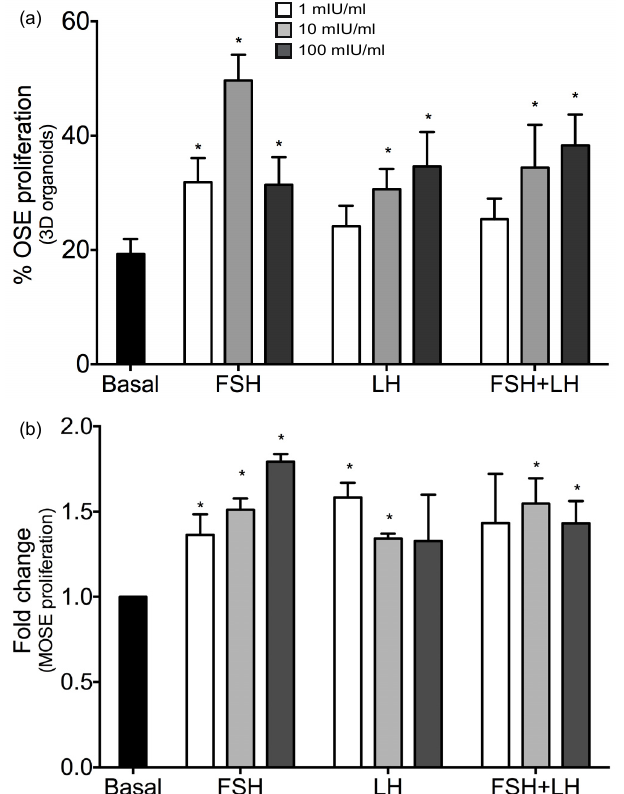
Figure 1. Gonadotropins increase ovarian surface epithelium (OSE) proliferation in 3D organoids and mouse ovarian surface epithelial (MOSE) cell line. ( a ) Using BrdU as a marker of DNA synthesis, the gonadotropins increased proliferation of OSE in organoids after 8 days. ( b ) Proliferation of MOSE cells in response to gonadotropin stimulation was measured by sulforhodamine B (SRB) assay after 8 days. * different than basal p <